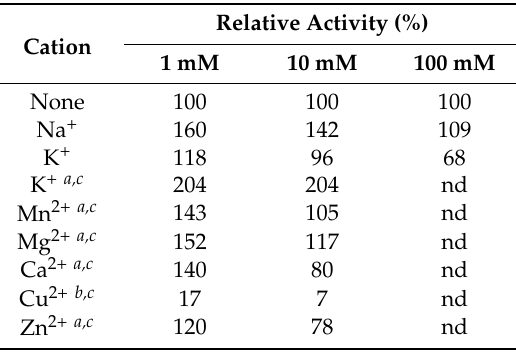
Table 3. Effect of various cations on activity of recombinant β -galactosidase from L. helveticus expressed in E. coli ( EcoliBL21Lh β